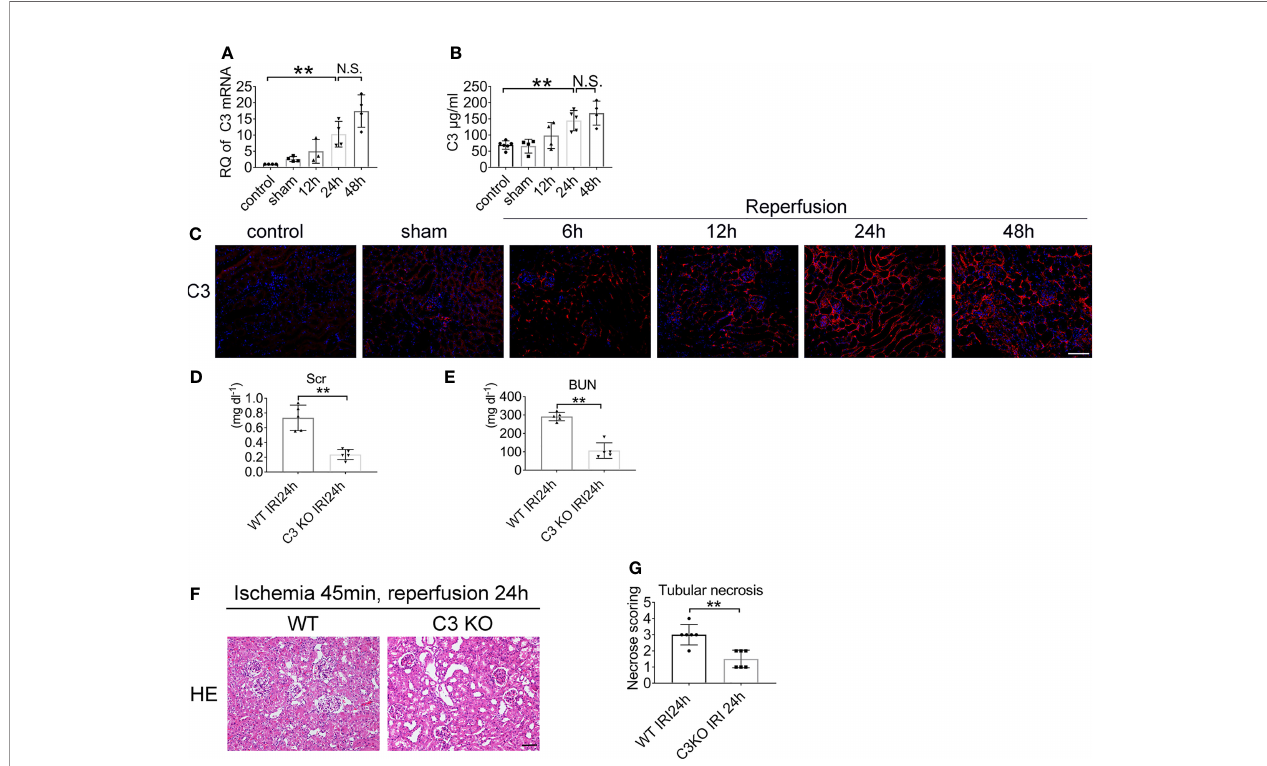
FIGURE 5 | Renal IRI leads to C3 activation and C3 de fi ciency ameliorates IRI. Levels of C3 in renal tissue after IRI or sham surgery in WT mice were measured by qPCR (A) and ELISA (B) , n = 4 – 6/group. (C) Representative immuno fl uorescence microscopy image of C3 staining in kidney from WT mice subjected to renal IRI, n = 6/group. Plasma creatinine (D) , and urea nitrogen (E) 24 h after IRI in WT and C3 KO mice, n = 5 – 6/group. (F) Representative HE staining of kidney 24 h after IRI in WT and C3 KO mice. n = 5 – 6/group. (G) Score for histopathology of tubular damage after renal IRI using HE stained renal tissue sections. **P < 0.01. N.S., No Signi fi cance. Data are presented as mean ±